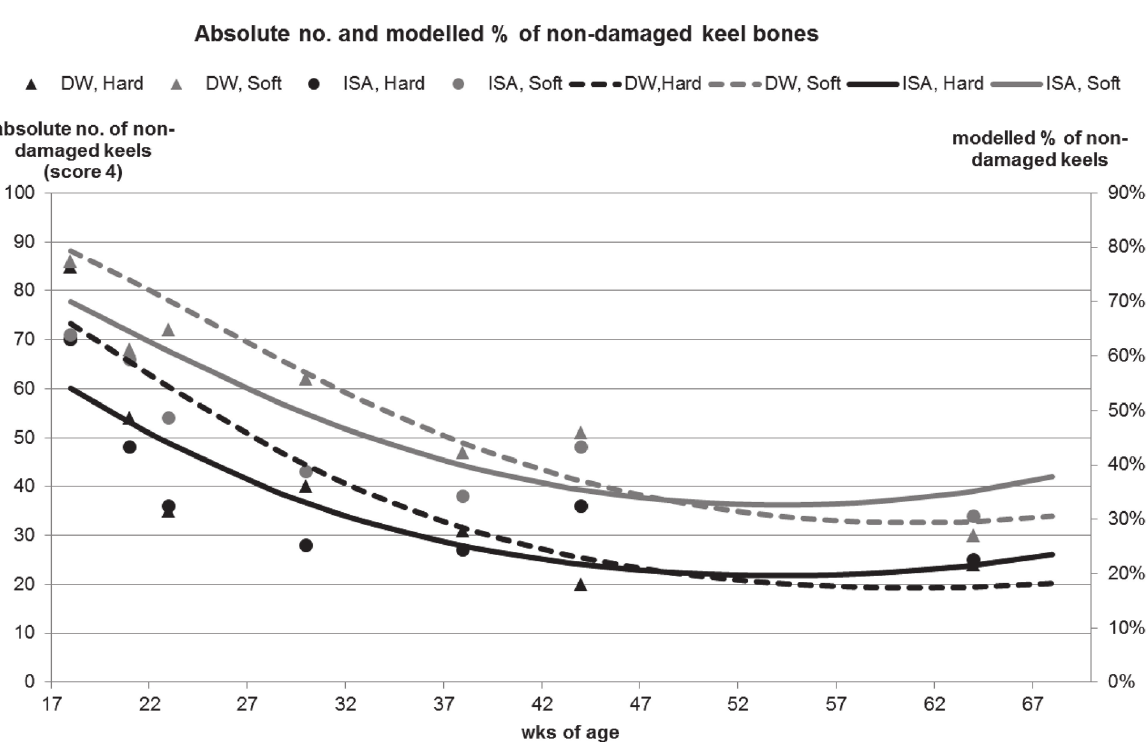
Fig 2. Non-damaged keel bones. Absolute numbers and modelled % of birds with a non-damaged keel bone over the course of the experiment for each of the four perch type by genetic line combinations.